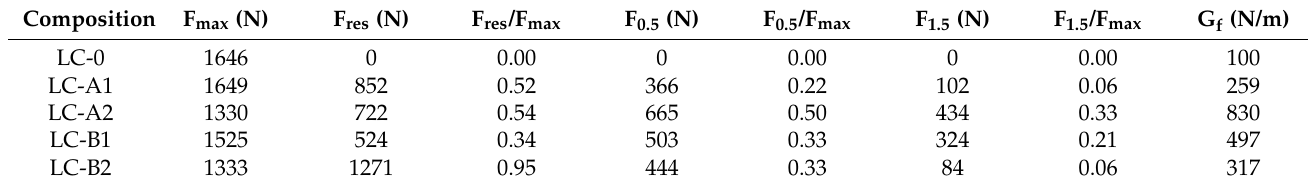
Figure 4. “Load–deflection” curves for specimens subjected to bending: LC-0, LC-A1, LC-A2, LC-B1, LC-B2. Table 6. Bending characteristics values and bending energy for tested specimens .